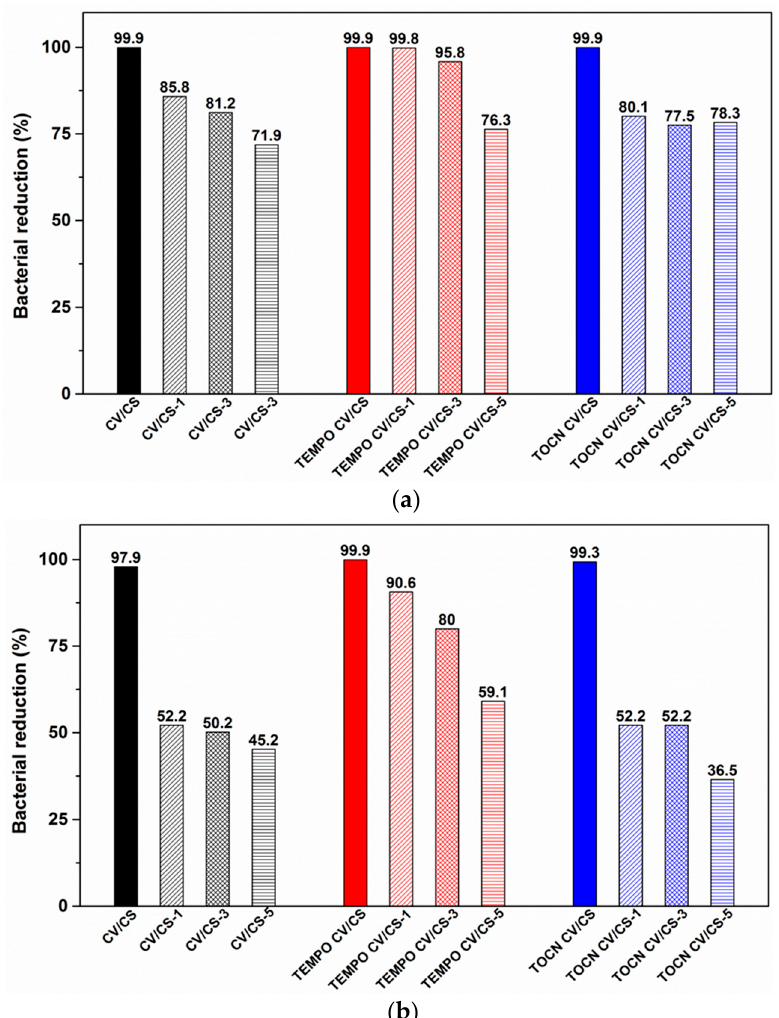
Figure 7. Bacterial reduction of pristine and pretreated viscose fabrics functionalized with chitosan after one, three and five washing cycles against Staphylococcus aureus ( a ) and Escherichia coli ( b ).